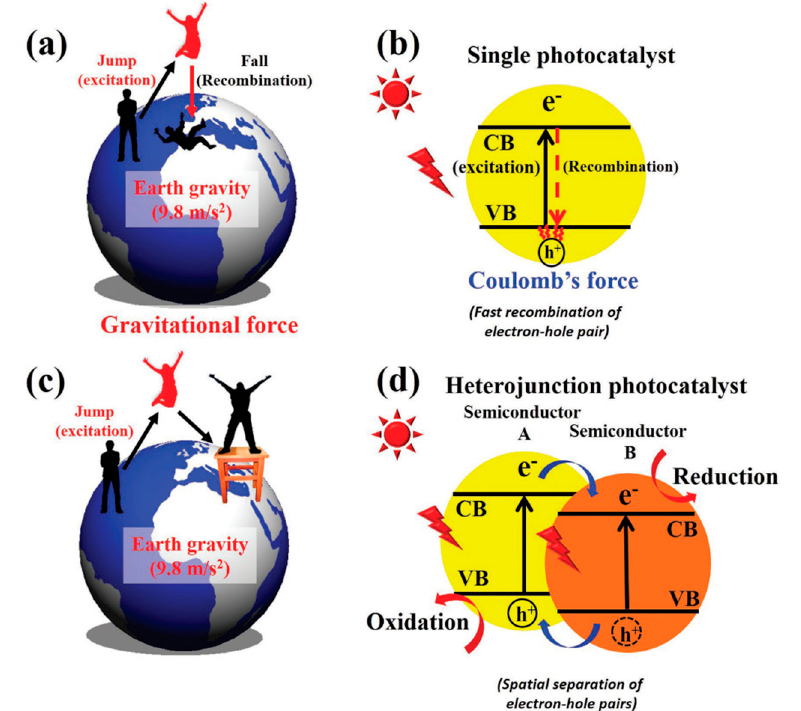
Figure 6. Schematics of ( a ) the influence of gravitational force on a man jumping; ( b ) recombination of photocatalyst electron–hole pair; ( c ) using stool to keep a man from returning to the ground; and ( d ) electron–hole pairs separated in a heterojunction photocatalyst. Reproduced with permission from [63]; copyright (2017), John Wiley & Sons, Inc.